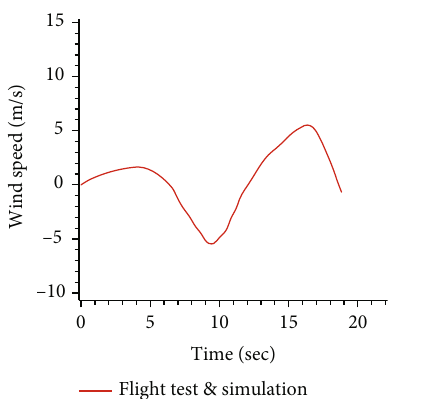
Figure 18: The target Quad-Plane is controlled manually to fl y sideward in VTOL mode to generate relative motion between the windless atmosphere and the Quad-Plane.